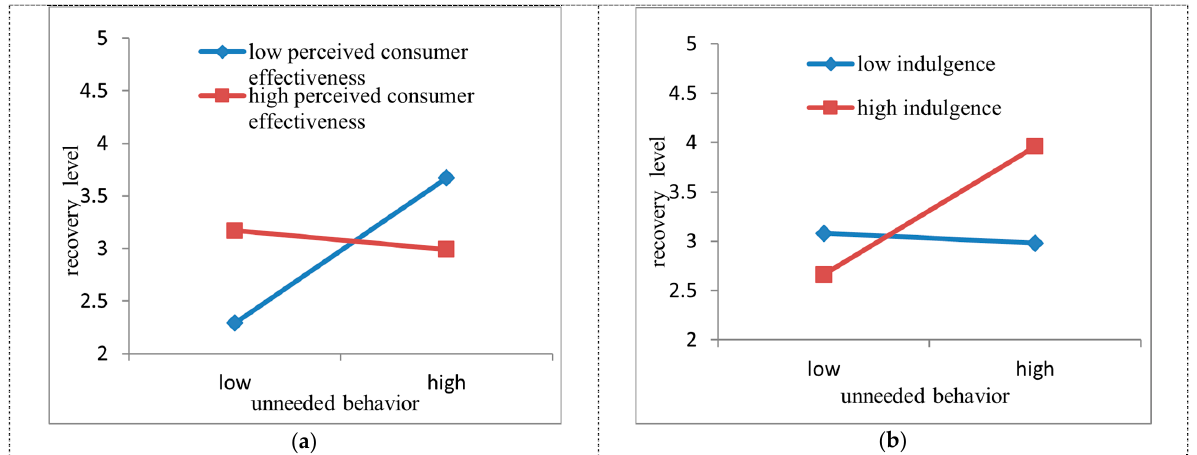
Figure 2. Moderation Plots. ( a ) perceived consumer effectiveness, ( b )